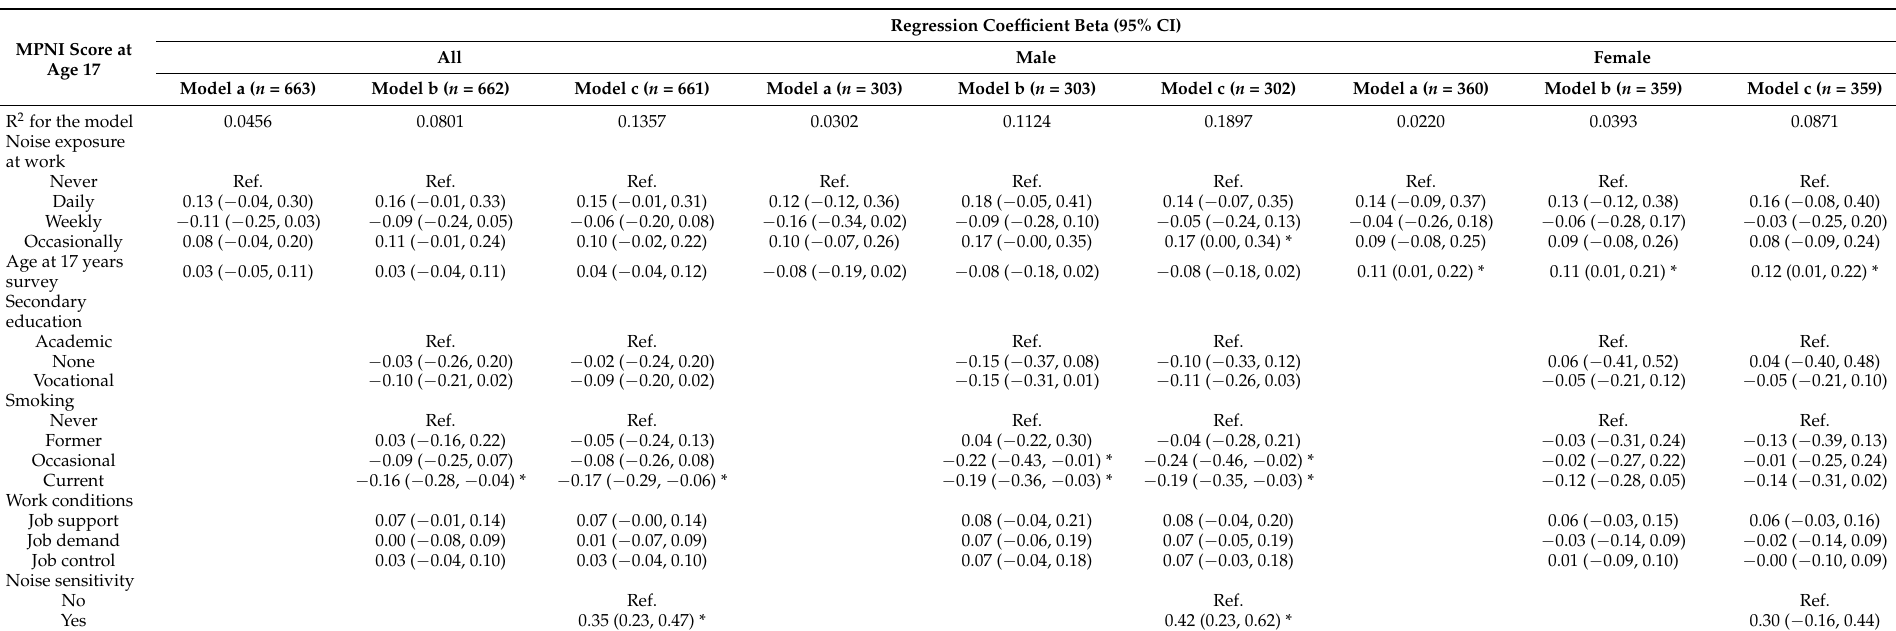
Table A2. Linear multivariable regression models of the association of depressive symptoms at age 17 using the MPNI scale with perceived occupational noise exposure and selected covariates in young